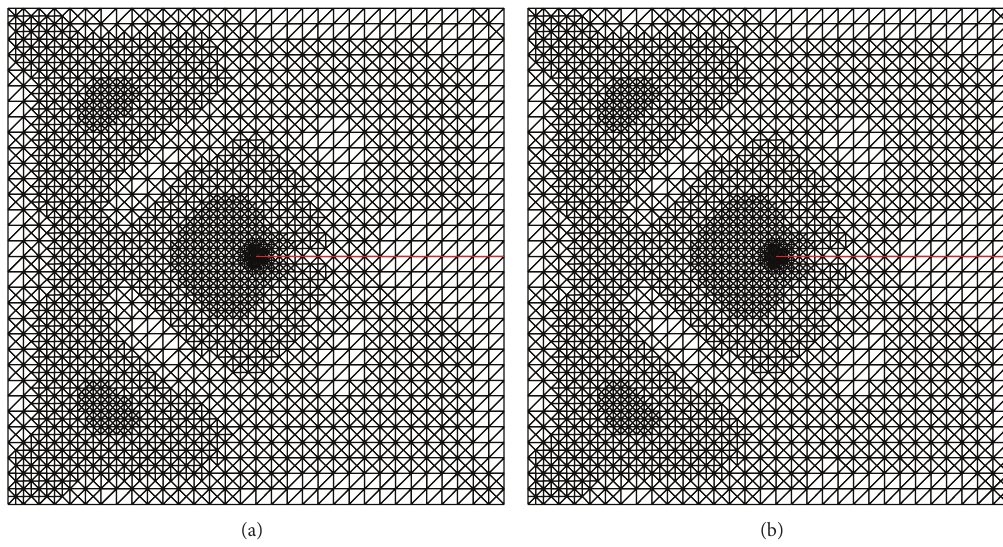
Figure 6: The adaptive meshes of 6th eigenvalue after 5th iteration by Algorithm 10 (a) and Algorithm 11 (b).